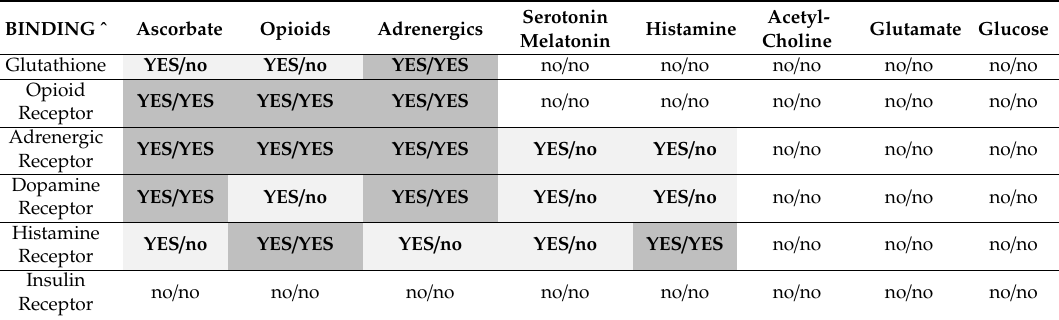
Table 3. Overall patterns of binding between classes of compounds and receptor types. ˆ Kd < or = 60 µ M but > 15 µ M / Kd < or = 15 µ M. Classes of compounds that bound to a receptor type at both cuto ff values are shown bolded on a medium gray background; classes of compounds that bound to a receptor type only between 16 and 60 µ M are bolded on a light gray background, while those that met neither cuto ff value are normal type on a white background.